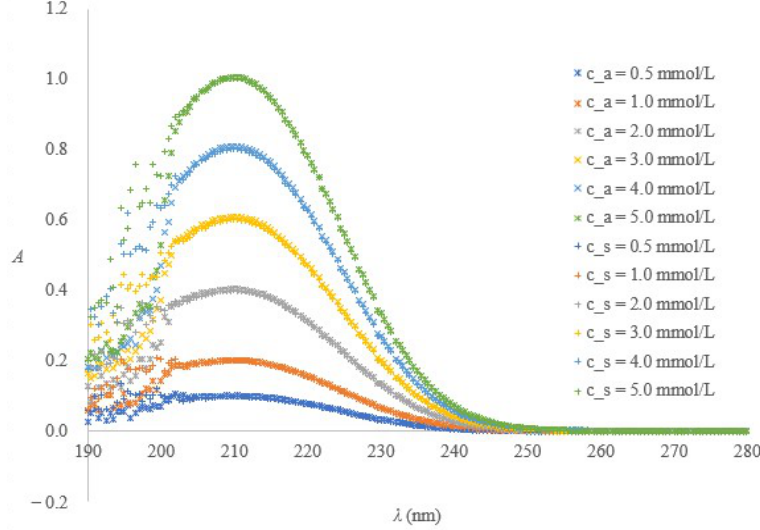
Figure 1. Citrate and citric acid model solutions-based confirmation that the suggested spectromet- ric method, independently of the initial equilibrium forms, ensures identical absorption spectra (c_a and c_s denote the citric acid and trisodium citrate amount concentration).